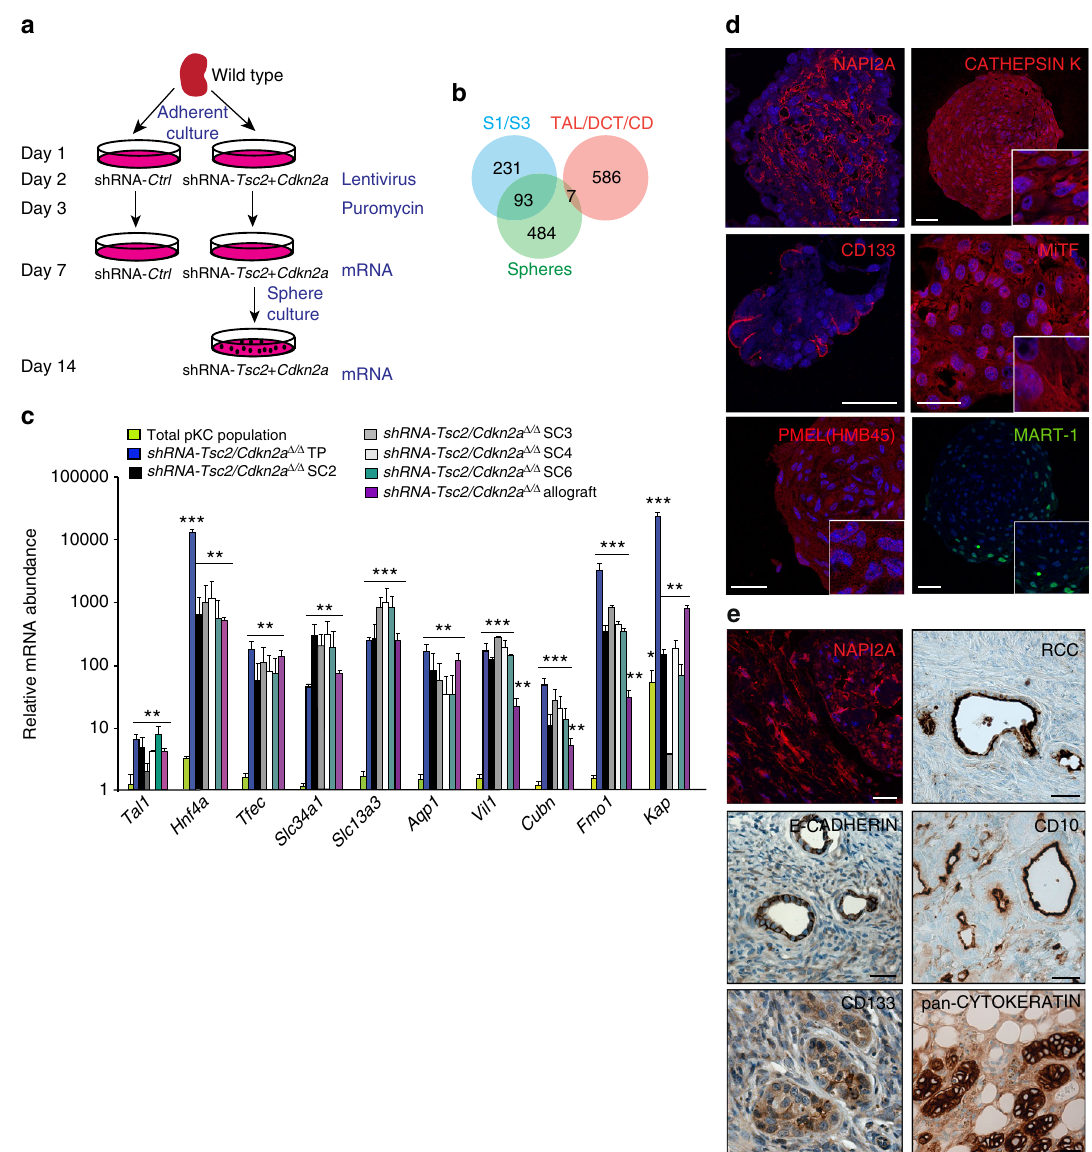
Fig. 3 Engineered sphere cells exhibit gene expression patterns of proximal tubule epithelial cells. a Overview of experimental procedure to identify the gene expression pro fi le of engineered shRNA- Tsc2 + Cdkn2a AML-forming sphere cells. b Venn diagram showing the overlap of gene expression signature of engineered spheres (green) with distinct mRNA signatures of S1 and S3 segments of proximal tubules (blue) or a pooled mRNA signature of DCT (distal convoluted tubule), TAL (thick ascending limb of the Loop of Henle) and CD (collecting duct) (red). c Real time PCR analysis of the indicated genes in cultures of control kidney cells (total pKC population), total sphere populations, sphere cultures of SC2, SC3, SC4 and SC6 and AML-like allograft tumours. Graph depicts mean ± s.d. Student ’ s t test, n = 3. ∗∗ P < 0.01; ∗∗∗ P < 0.001. d Positive immuno fl uorescence stainings of spheres using antibodies against NAPI2A, CATHEPSIN K, pan-CD133, MiTF, PMEL(HMB45) and MART-1. e Positive immuno fl uorescence and immunohistochemical stainings of AML-like allograft tumours using antibodies against NAPI2A, RCC, E-CADHERIN, CD10, CD133 and pan-CYTOKERATIN. Scale bars: 50 μ Fig. 8b), also argues against an induced pluripotent stem cell phenotype of our engineered sphere cells.